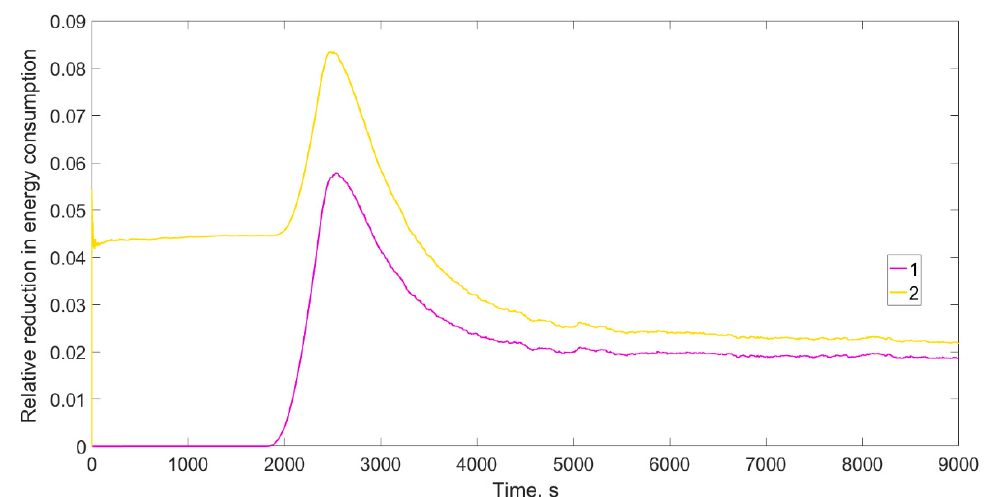
Figure 18. Course of the relative decrease in energy usage for control systems with a noise of 3%: 1—(relay—PID) and 2—(relay—I-PD).